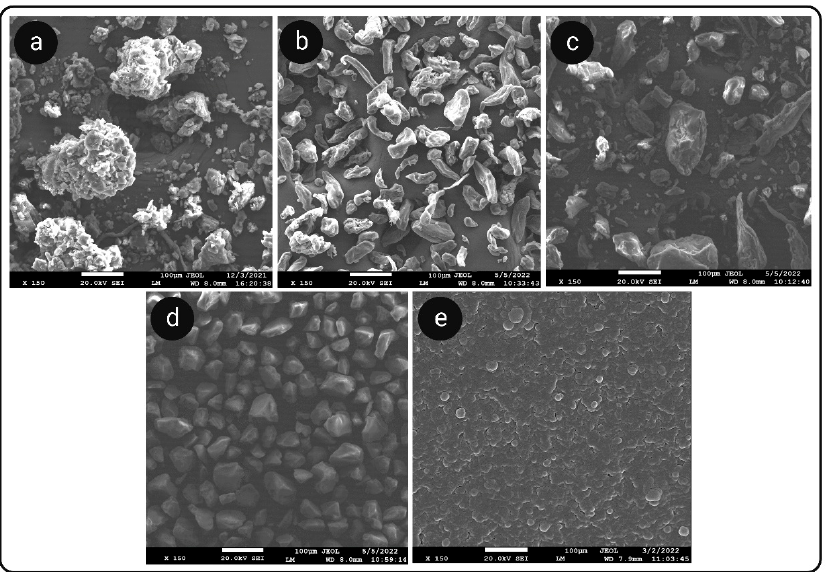
Figure 3. SEM images of ( a ) raw XH; ( b ) Guar gum; ( c ) Pectin; ( d ) Syloid XDP3150; ( e ) S-SNEDDS Figure 3. SEMimagesof( a )rawXH;( b )Guargum; ( c )Pectin; ( d )SyloidXDP3150; ( e ) S-SNEDDS powder .